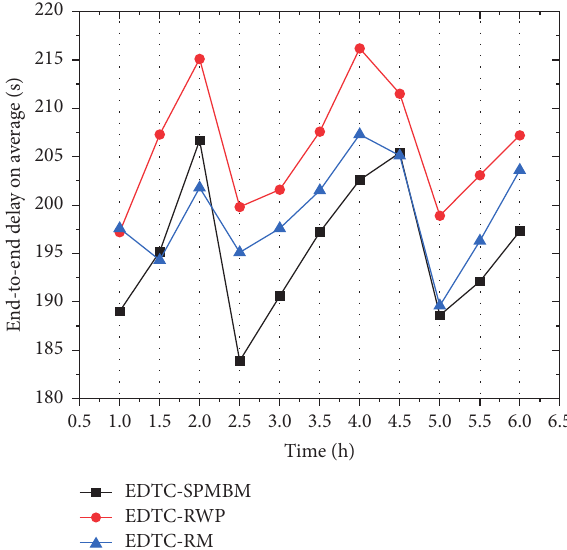
Figure 23: Relationship between end-to-end delay on average and time in three mobile models.